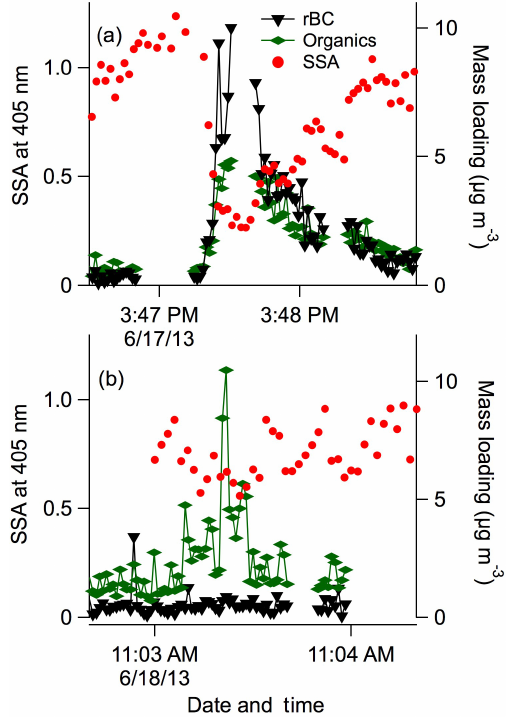
Figure 6. Examples of rBC-dominated (a) and organic- dominated (b) plumes observed using the SP-AMS with high-time-resolution (1Hz) sampling, with measurements of single scattering albedo (SSA) at 405nm from a photoacoustic soot spectrometer (PASS-3). Gaps in SP-AMS data correspond to periods used for the subtraction of gas-phase contributions from particle signals. Mass spectra shown in Fig. 1g and h correspond to plumes in (b) and (a) ,